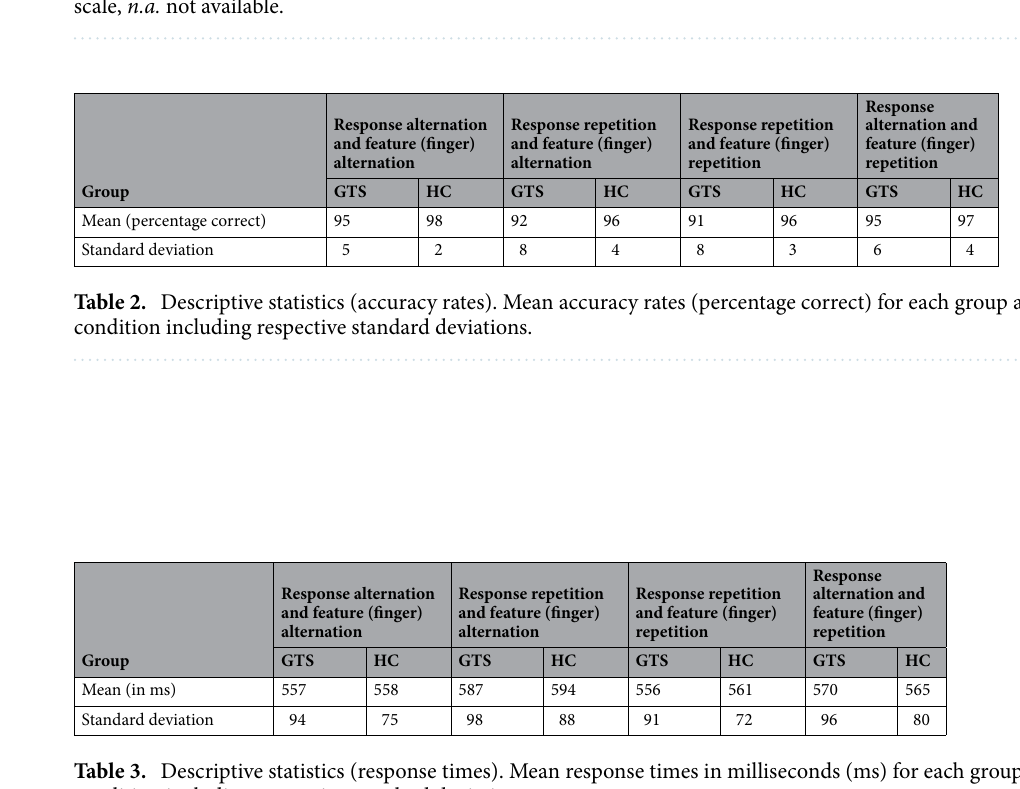
Table 1. Clinical characteristics of GTS patients. Compilation of clinical characteristics of GTS patients in tabular form. Shown are age, sex, and scores of the respective assessments. Details on each assessment can be found in the text. ADHD attention deficit/hyperactivity disorder, DCI diagnostic confidence index, PUTS premonitory urge for tic scale, YBOCS Yale Brown obsessive compulsive scale, YGTSS Yale global tic severity scale, n.a. not available.